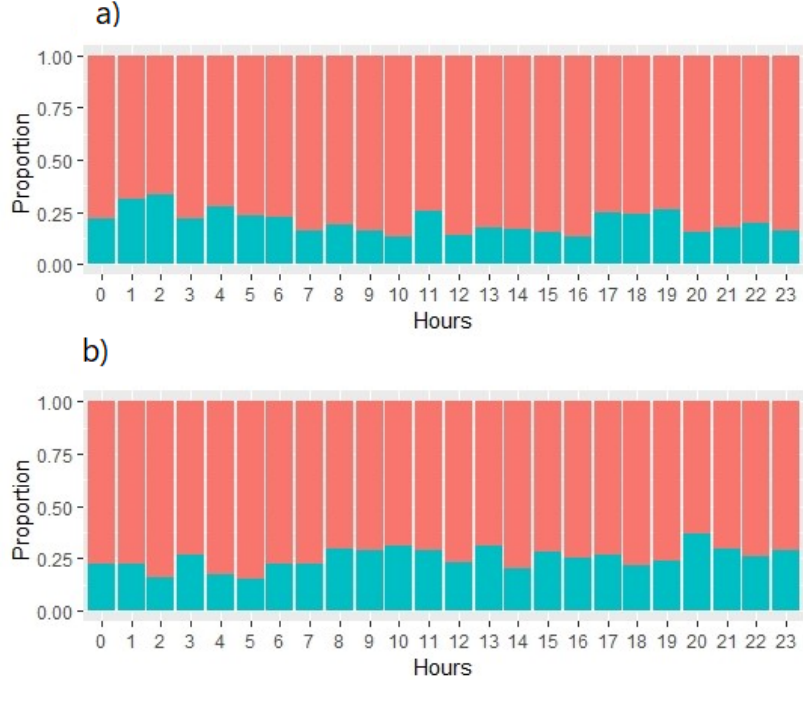
Figure 4. (a) Activator nurse interpretation suggesting acute myocardial infarction and computer disagreed; (b) computer interpretation suggesting acute myocardial infarction and activator nurse